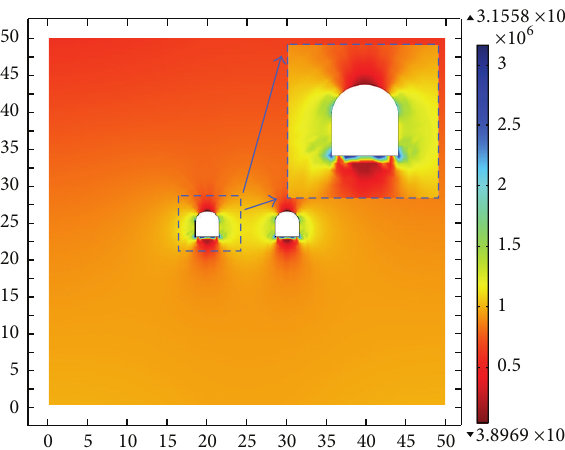
Figure 17: Contours of the first principal stress for 𝜃 = 15 ∘ case.